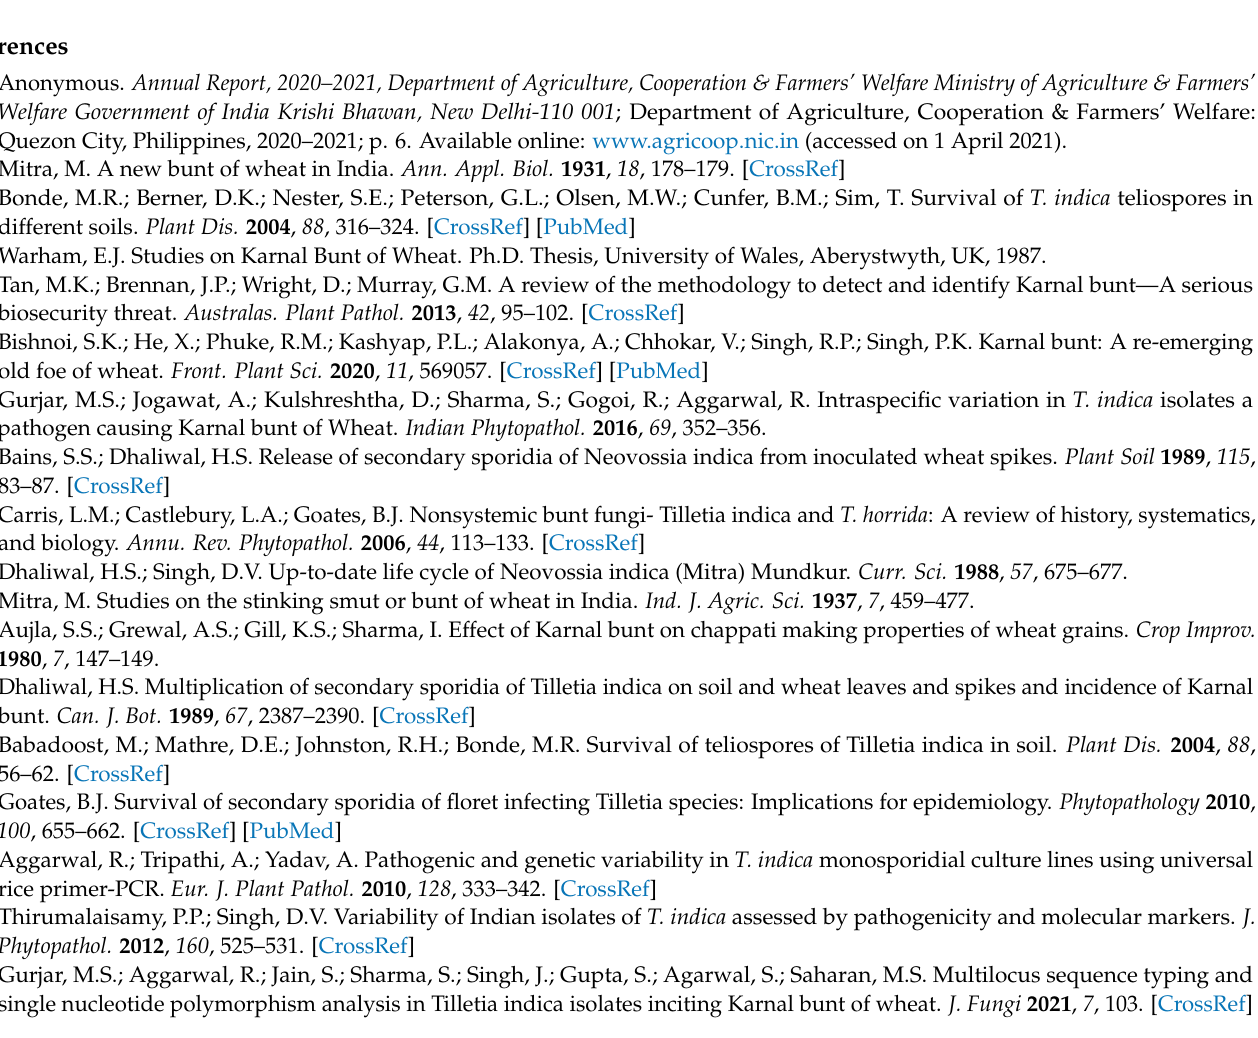
Table S5: Identified KEGG pathways and functional categories; Table S6: Differentially expressed defense-related genes; Table S7: Gene expression analysis with annotation with T. indica in the resistant and susceptible